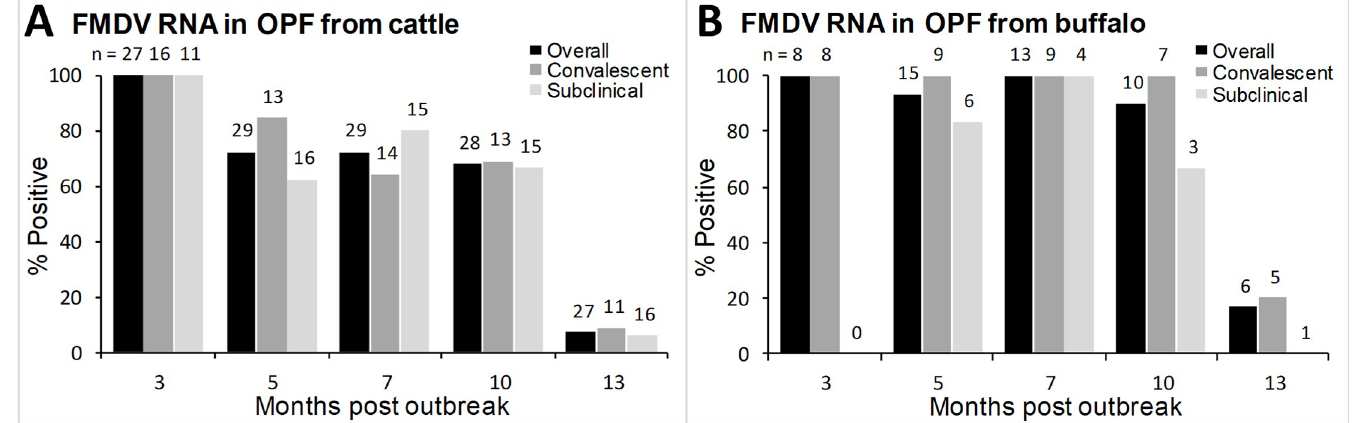
Fig 1. Proportion of convalescent (post-clinical), subclinical, and overall carrier cattle (A) and buffalo (B) from which FMDV RNA was detected in OPF . Numbers indicate the total number of animals sampled at each sampling period.